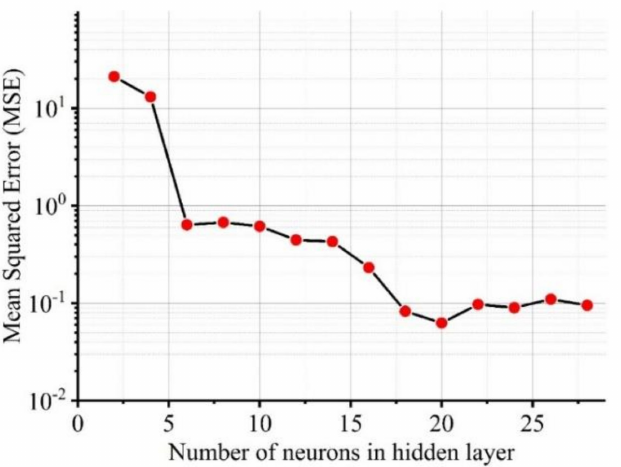
Figure 9. Dependence of the mean squared error (MSE) in the hidden layer vs. the number of neurons.